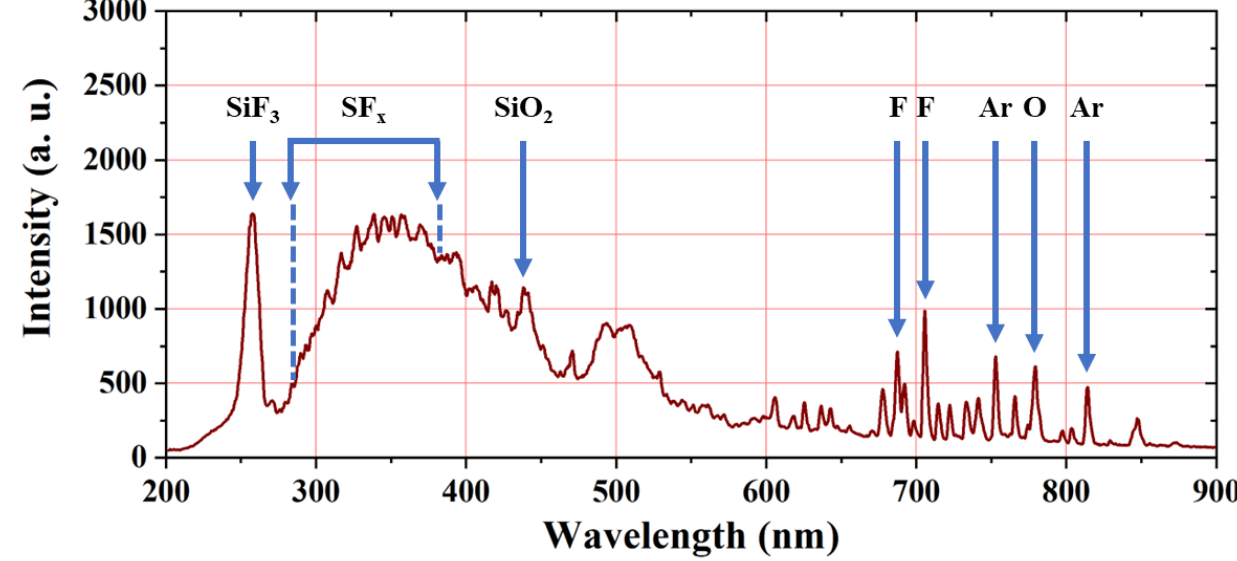
Figure 2. An example of OES data of atoms and molecules in SF 6 /O 2 /Ar plasma.